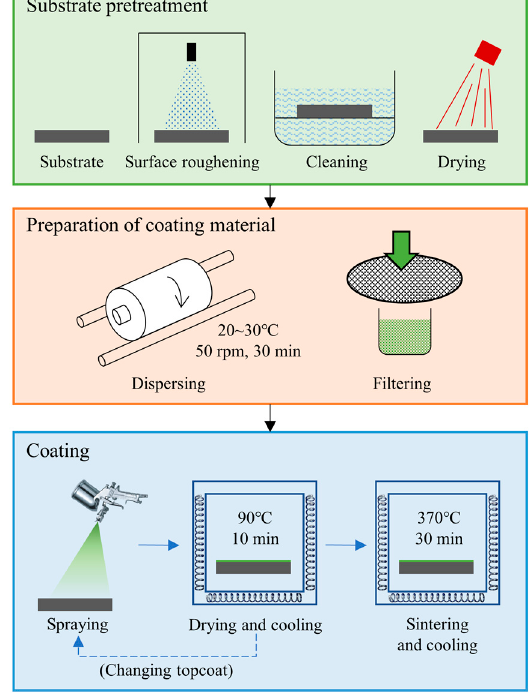
Figure 2. Preparation progress of coating specimens.